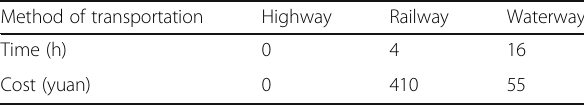
Table 2 Operation data for the optimal path constrained by a mixed time window Method of transportation